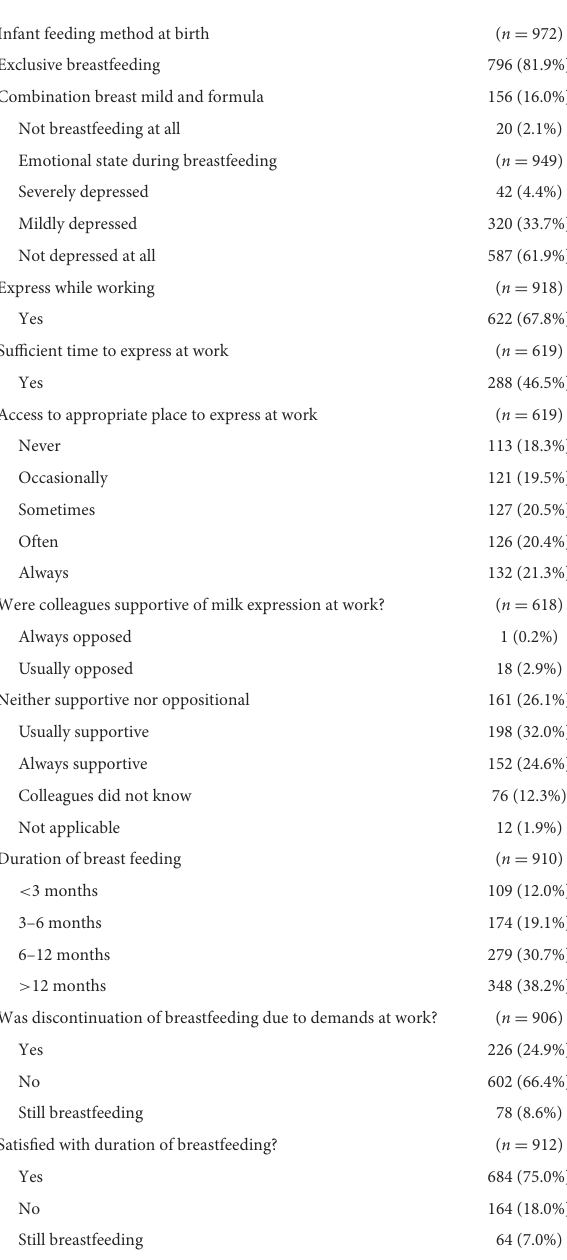
TABLE 4 Breastfeeding practices among ANZ